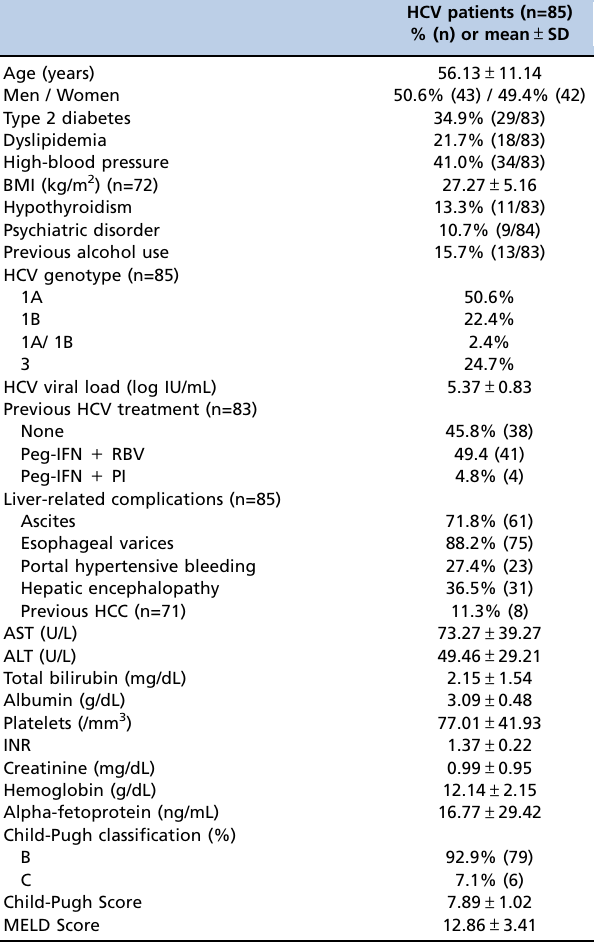
Table 1 - Demographic, clinical and biochemical characteristics of patients with HCV (n=85).